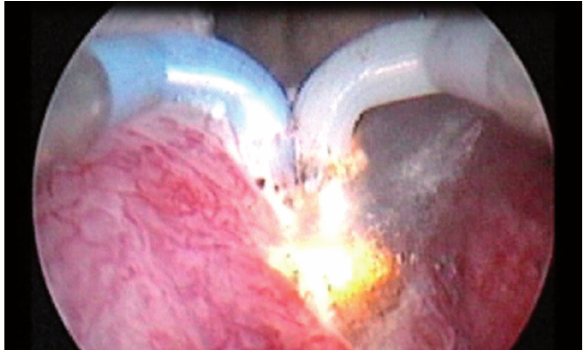
Figure 2 - Transurethral PKVP of the right lobe of the prostate.